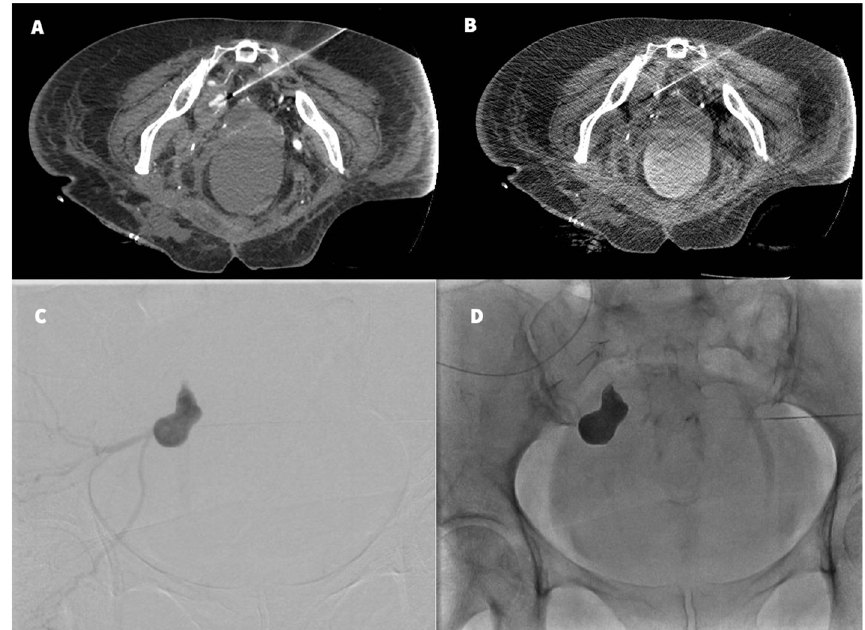
Fig. 2 Direct percutaneous access to the mycotic pseudoaneurysm under CT guidance. A ) Tip of the 20 G needle medial to the left internal iliac artery mycotic pseudoaneurysm sac on CT angiogram just before access to the sac. B ) Direct access into the sac with 20 G needle. C ) Contrast injection under fluoroscopy opacifies the left internal iliac artery mycotic pseudoaneurysm sac and feeding arteries. D ) Onyx embolization of the